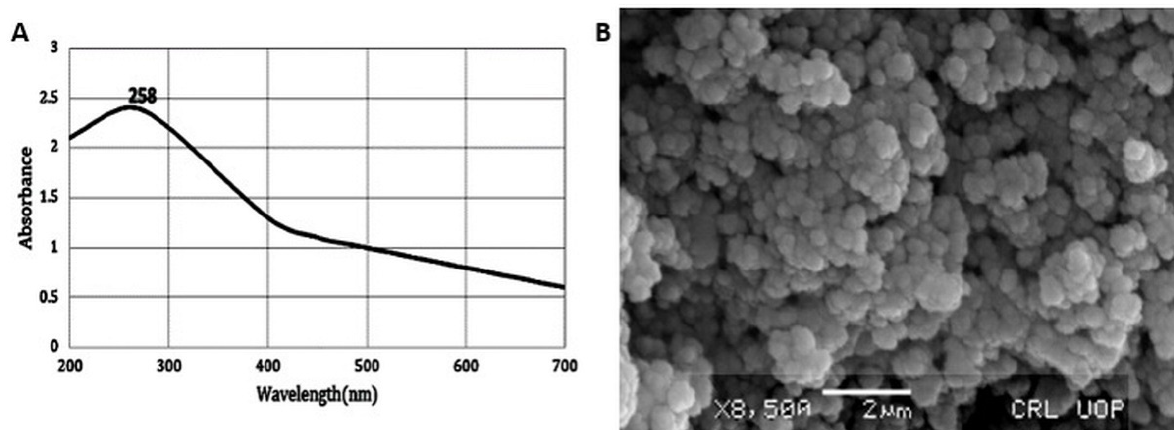
Molecules 2022 , 27 , x FOR PEER REVIEW 3 of 11 Figure 2. ( A ) UV—Visible Spectrum of SeNPs;( B ) SEM image of SeNPs. Figure 1. ( A ) UV—Visible Spectrum of SeNPs;( B ) SEM image of SeNPs.